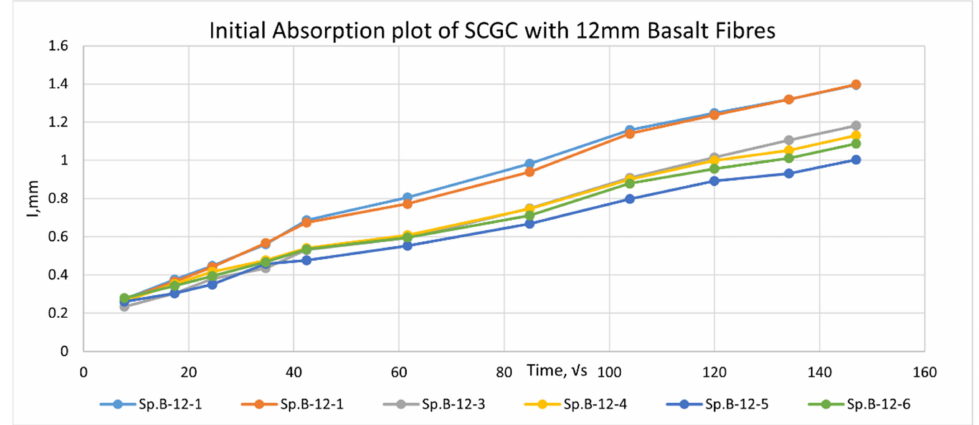
Figure 7. Initial absorption plot of SCGC with 12 mm basalt fibres. The secondary and long-term absorption rates of the 12 mm basalt fibre-containing mix are also shown in Figures 8 and 9 below: